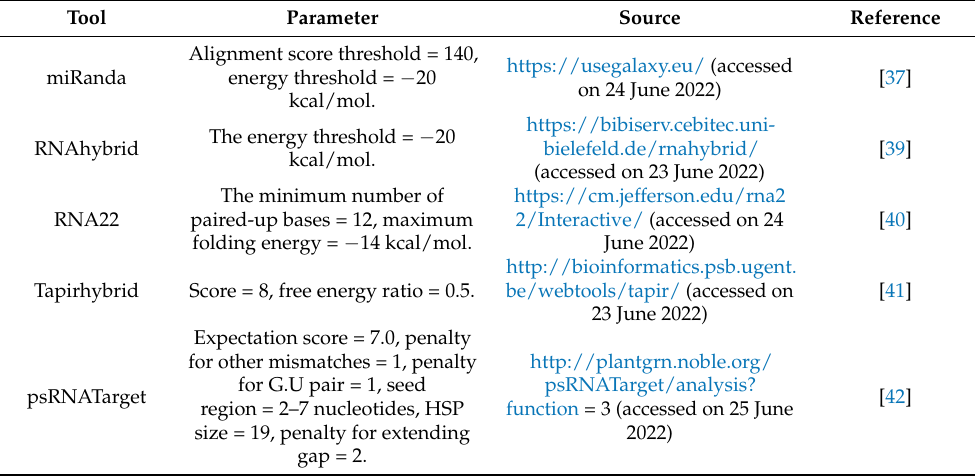
Table 1. Parameters used for each rice microRNA target site prediction algorithm in this